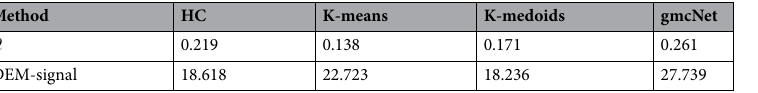
Table 1. Model performance on Korean native cattle dataset in terms of graph modularity Q and DEM signaling.